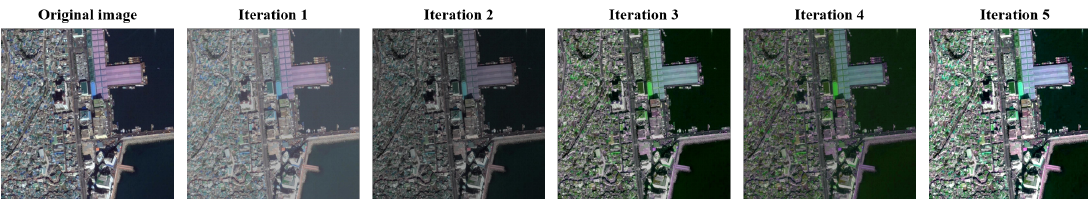
Figure 5. Internal augmented samples. In every iteration of training, the target image is augmented using random color-jittering. Therefore, in every iteration, the network considers a different augmented training